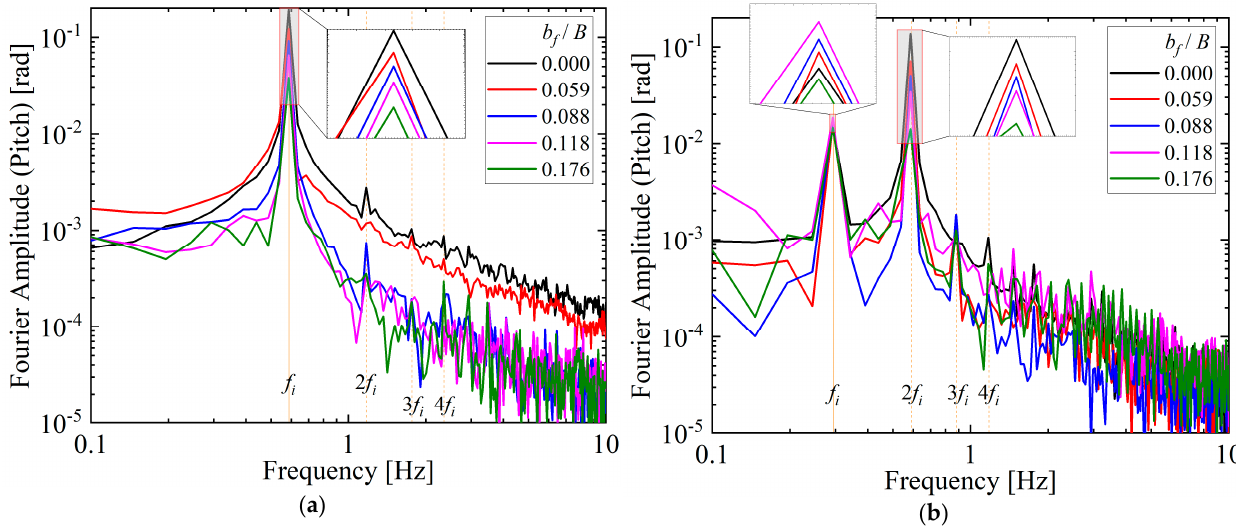
i = 0.88 Hz; ( b ) f i = 0.35 Hz.